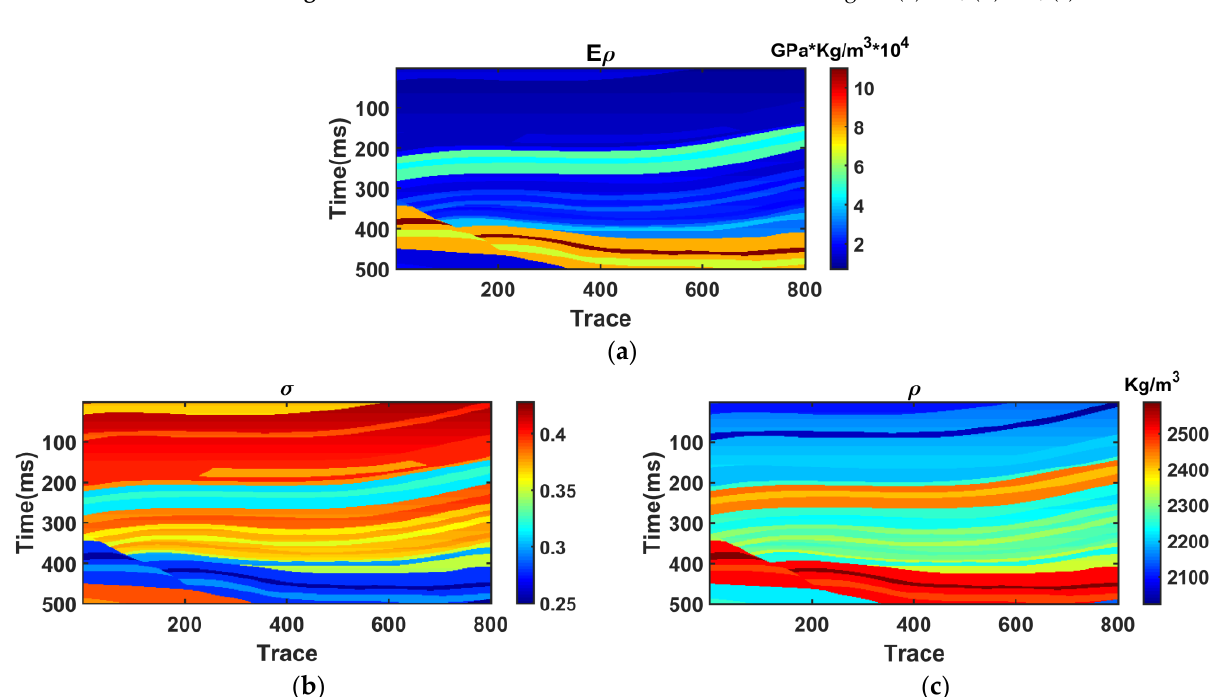
Figure 3. Theoretical models: (a) E ; (b) Poisson's ratio; (c) density.